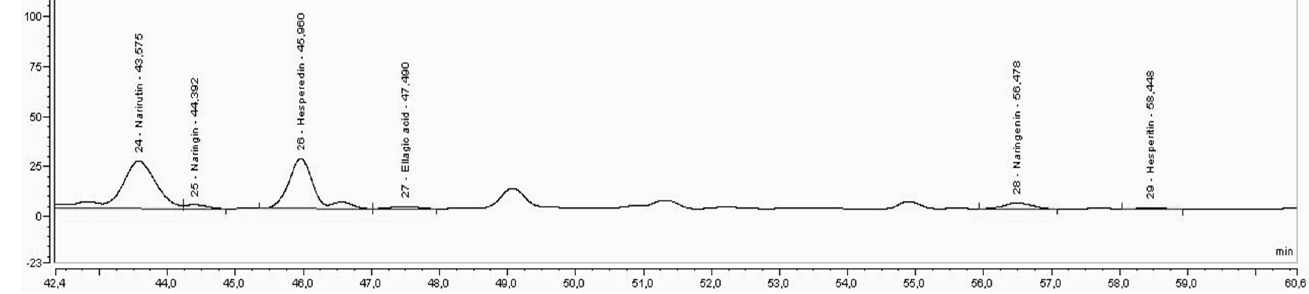
Figure 4. Chromatogram of the extraction performed with DES3 by one step.